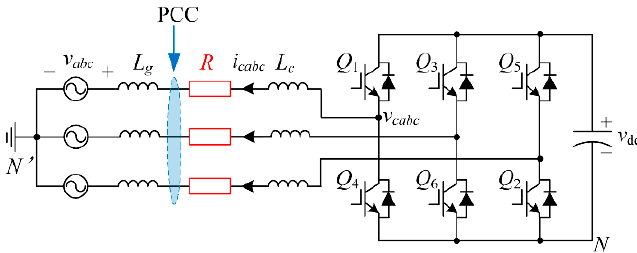
Figure 13. Schematic diagram of DSTATCOMs with filter resistors.